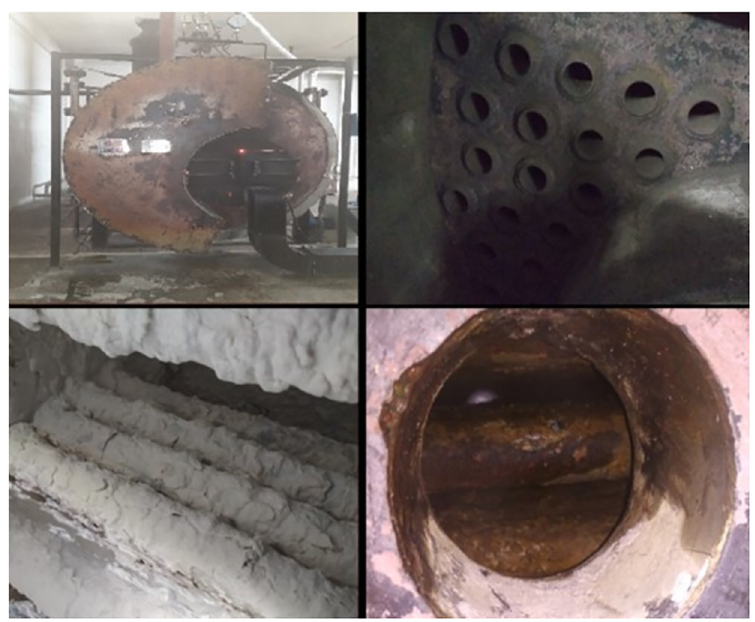
Fig 2. Heat dissipation from an uninsulated heated surface (Top-left), Rusted weld joint and carbon deposit due to unburnt fuel (Top-right), Corrosion of the boiler wall due to calcium build-up from untreated water (Bottom- left and Bottom-right)